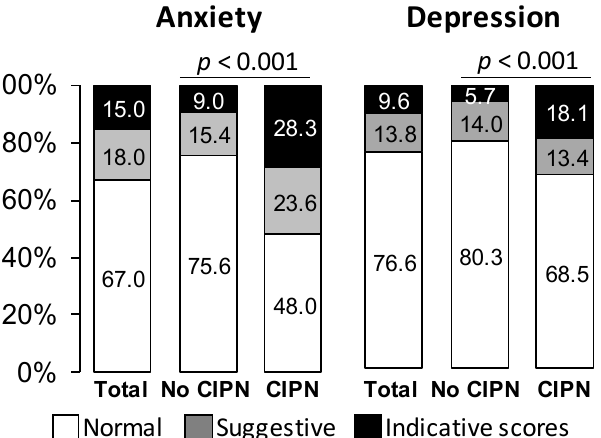
Figure 5. Proportion of patients with anxiety or depression (Hospital Anxiety and Depression scale) according to sensory CIPN. Results are expressed as percentages.